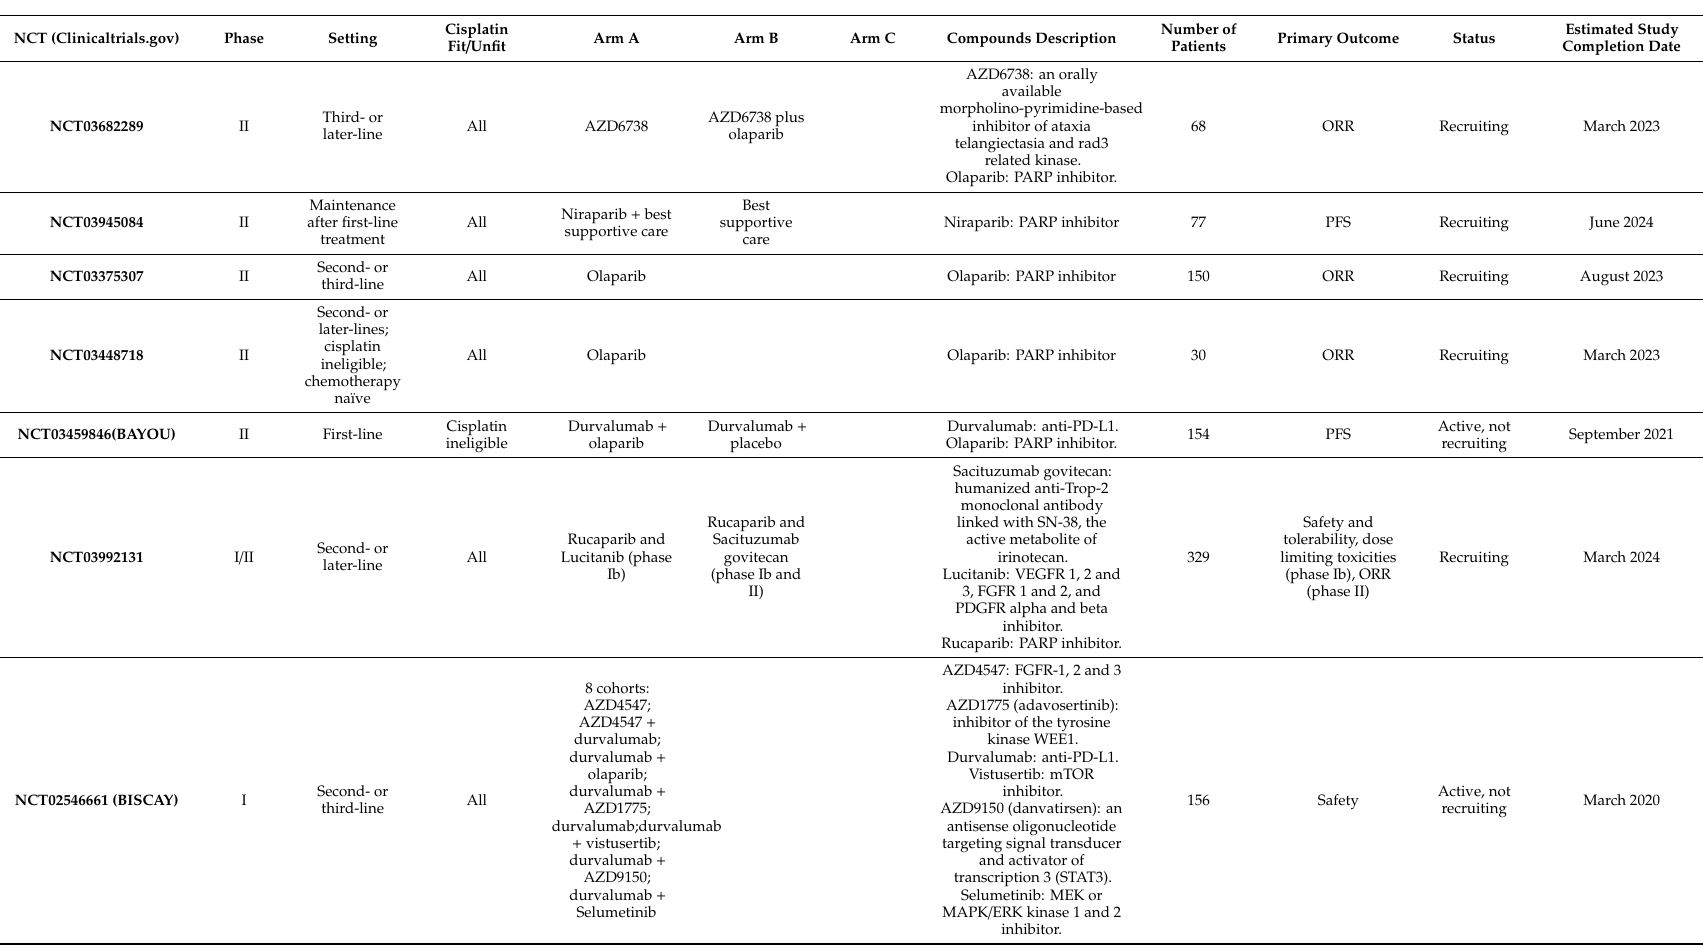
Table 6. Ongoing phase I / II / III trials of PARP inhibitors. ORR: overall response rate. PFS: progression-free survival. OS: overall survival. NCT